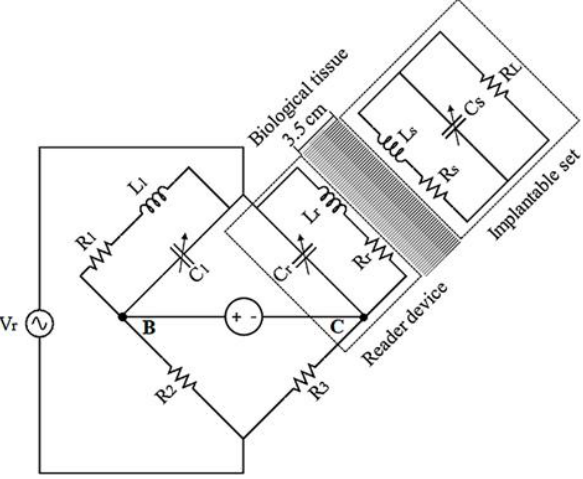
Figure 2. Inductive-coupling array (Maxwell–Wien bridge circuit) to perform transfer power and indirect ventricular pressure measurements.